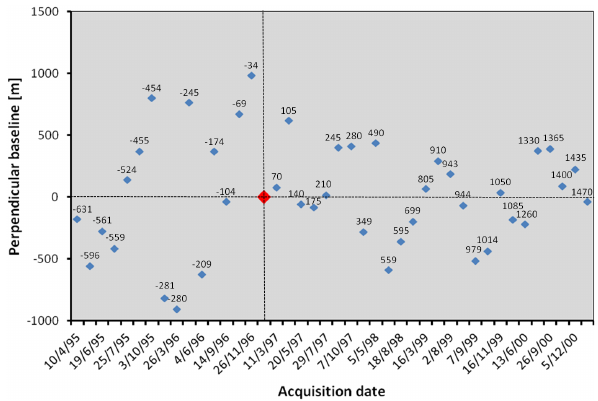
Fig. 3. Perpendicular baseline for each SAR scene of the PSI Figure 3. Perpendicular baseline for each SAR scene of the PSI dataset, labeled with the 812 dataset, labeled with the temporal baseline. Parameters are referred temporal baseline. Parameters are referred to the master image which is indicated with the red 813 to the master image which is indicated with the red diamond. 814 815